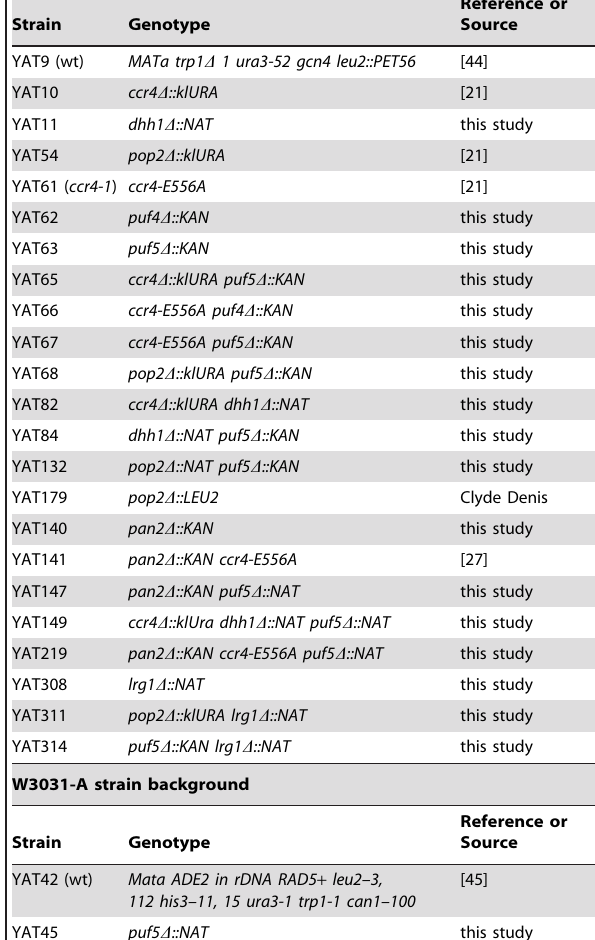
KY803 strain background